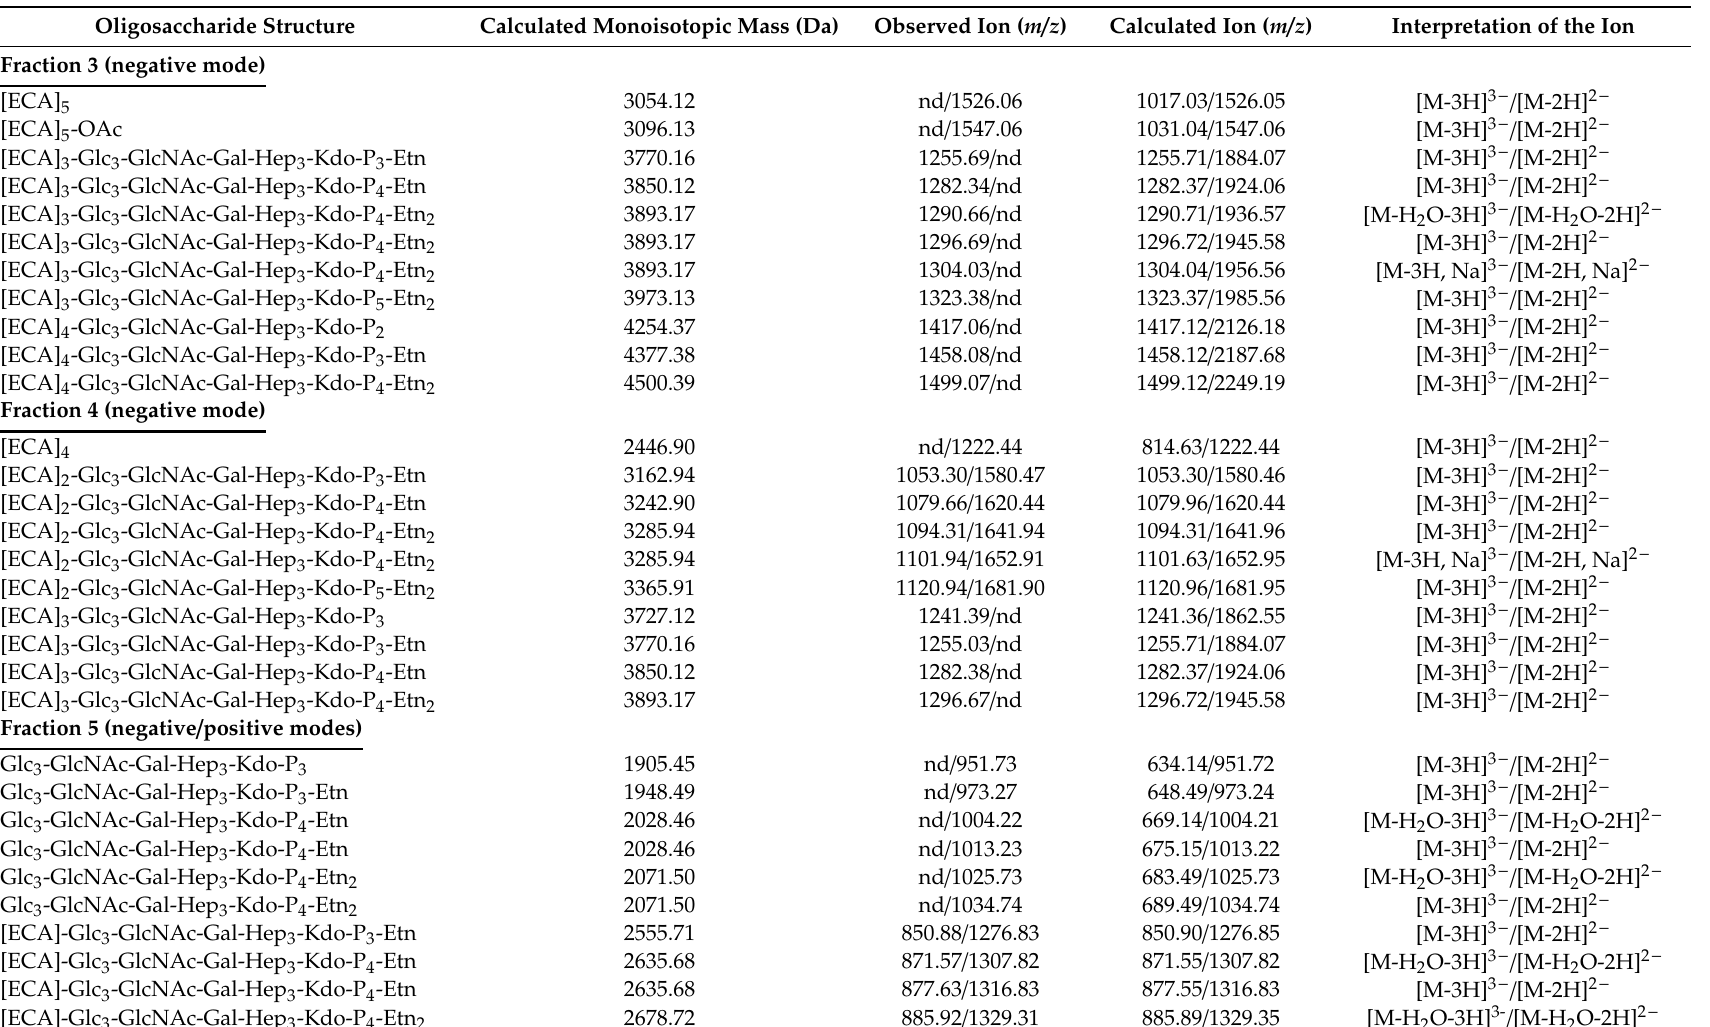
Table 3. Interpretation of ESI-IT mass spectra of [ECA] 2–4 -core OS glycoforms (fractions 3–5) isolated from E. coli R2 LOS